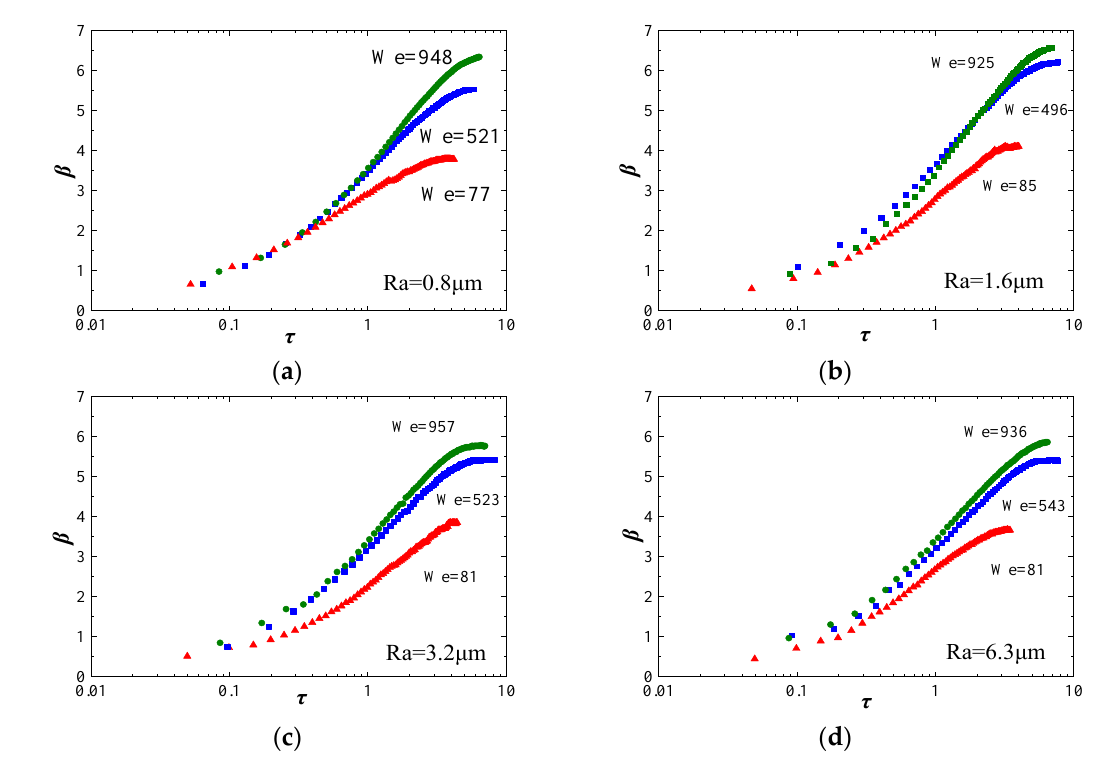
Figure 5. β - τ curves at different We . ( a ) Ra = 0.8 µm. ( b ) Ra = 1.6 µm. ( c ) Ra = 3.2 µm. ( d ) Ra = 6.3 µm.